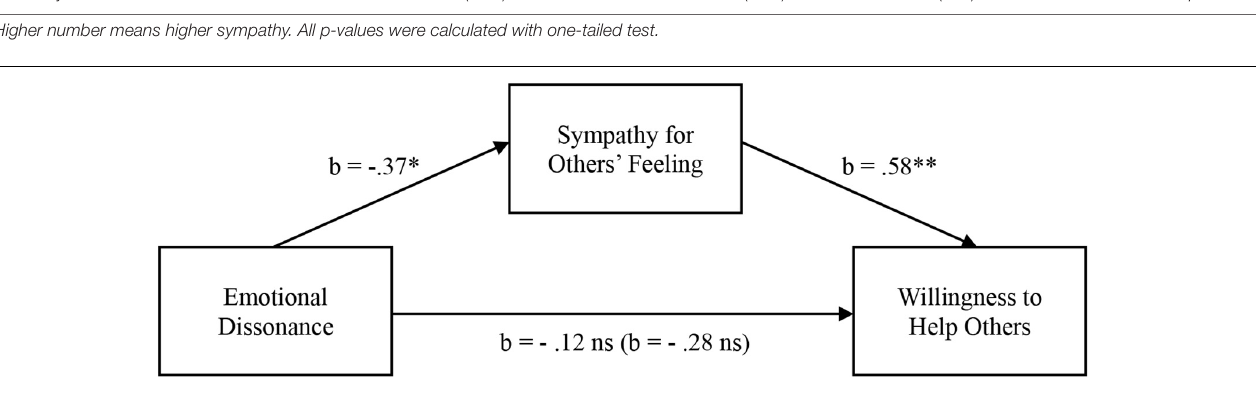
FIGURE 1 | Mediational analysis for Study 2A. ∗ p < 0.05, ∗∗ p <